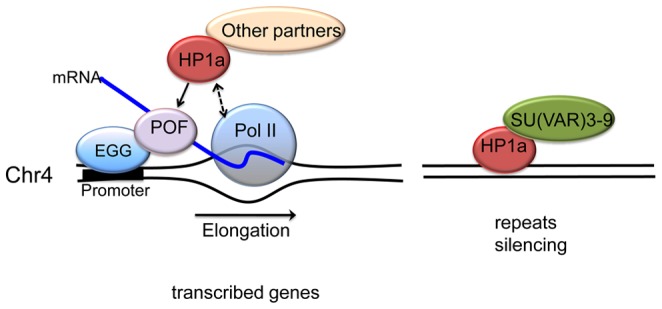
A model illustrating the two mechanisms proposed for HP1a assembly on chromosome 4.In active transcribed regions, POF and EGG are recruited, which leads to high levels of HP1a across the gene body (left). Details are unknown; POF is not reported to interact directly with HP1a, so other protein partners may be involved, in addition to HP1a binding to H3K9me2/3. The chromatin complex containing POF, HP1a and other partners has a general positive effect on RNA pol II – possibly by affecting transcription elongation - specifically on chromosome 4. In silent, repeat-rich regions, which lack POF enrichment, H3K9me marks deposited by a second histone methyltransferase (presumably SU(VAR)3-9) lead to a POF-independent assembly of HP1a–containing chromatin (right). Note that neither EGG, POF, nor SU(VAR)3-9 are known to interact directly with DNA; the binding described occurs in a chromatin context.